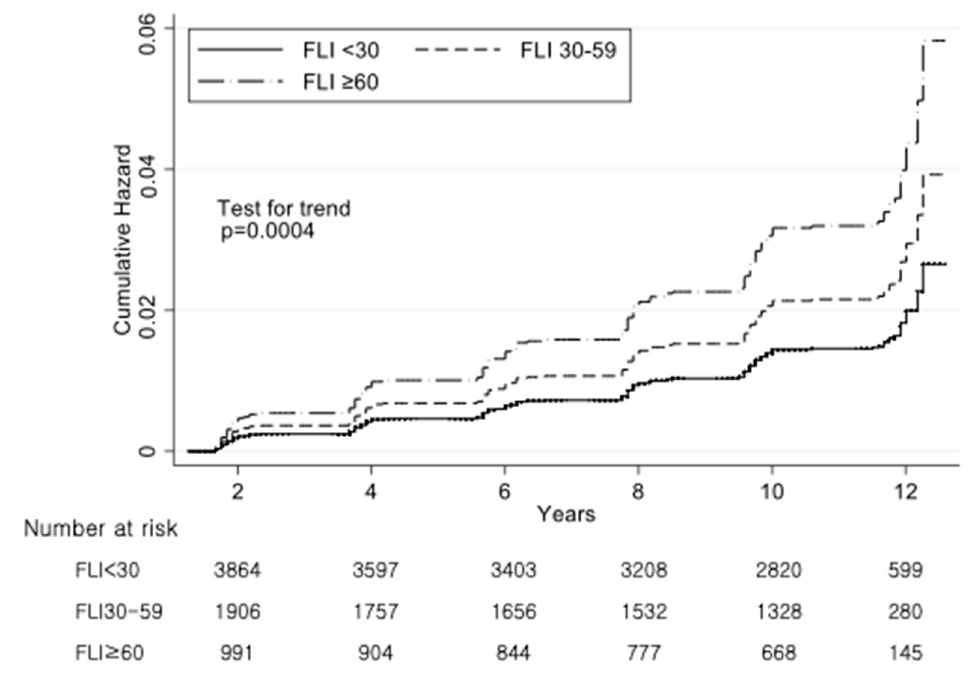
Figure 2. Adjusted cumulative hazard curves for the incidence of cerebrovascular diseases according to the FLI group. Adjusted for age, sex, hypertension, diabetes mellitus, hyperlipidemia, cardiovascular disease, smoking and alcohol status, body mass index (BMI), metabolic equivalent of task (MET), cancer, hyperlipidemia drug, antihypertension drug, aspartate aminotransferase (AST), alanine aminotransferase (ALT), γ -glutamyl transpeptidase (GTP). Estimated by Cox’s proportional hazard regression.